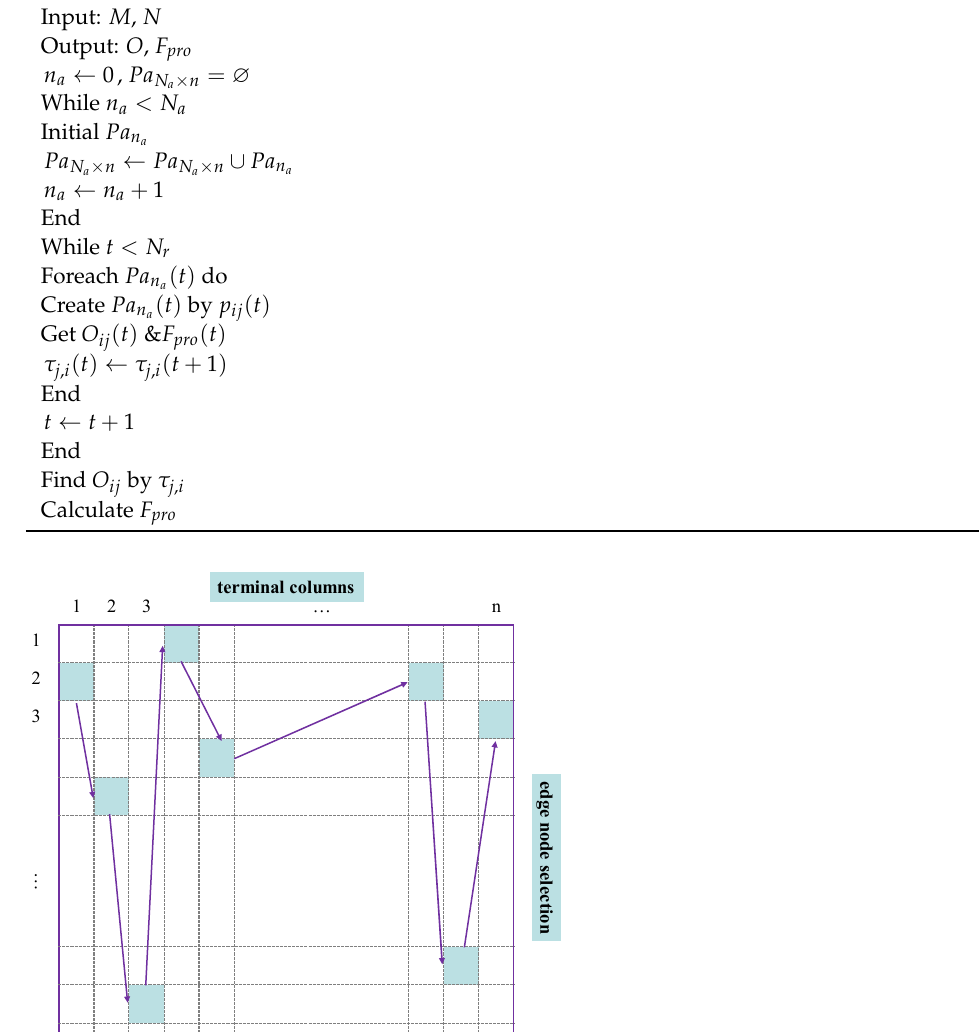
The information factor ( ph α ) indicates the degree to which the ant’s path selection is influenced by the pheromone. There are a total of Na ants, and the ant is defined as a n .